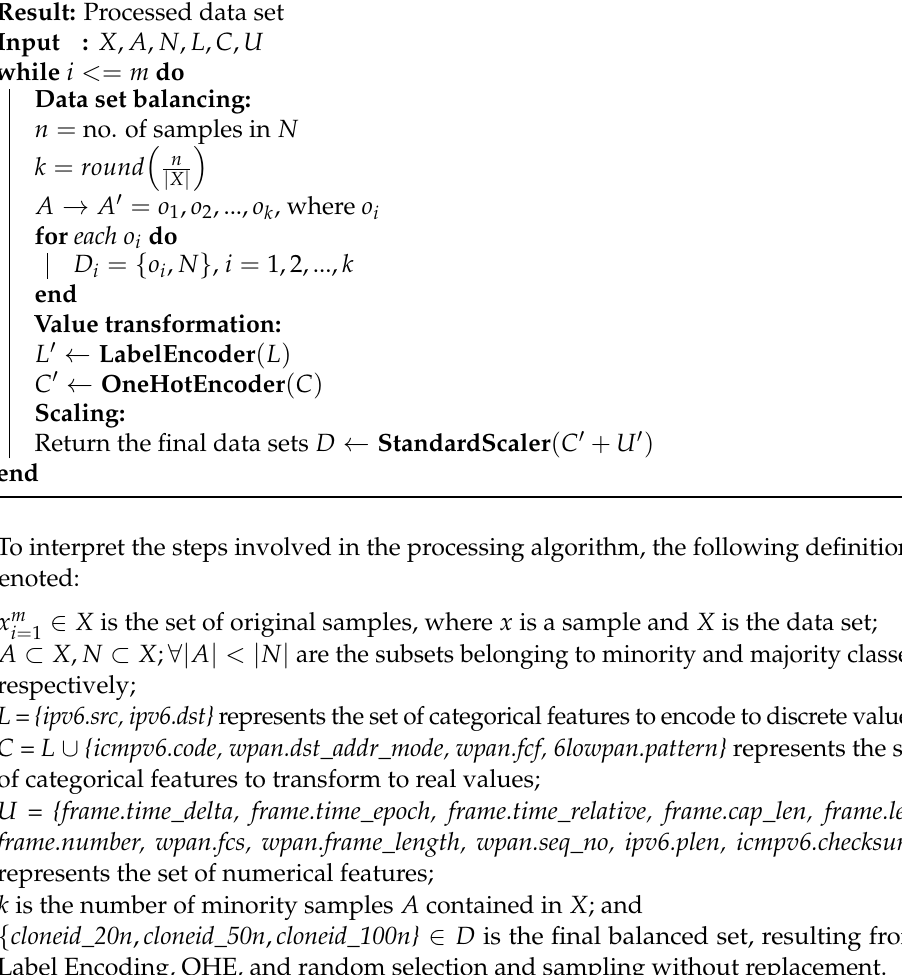
Algorithm 1: Preprocessing tasks over each data